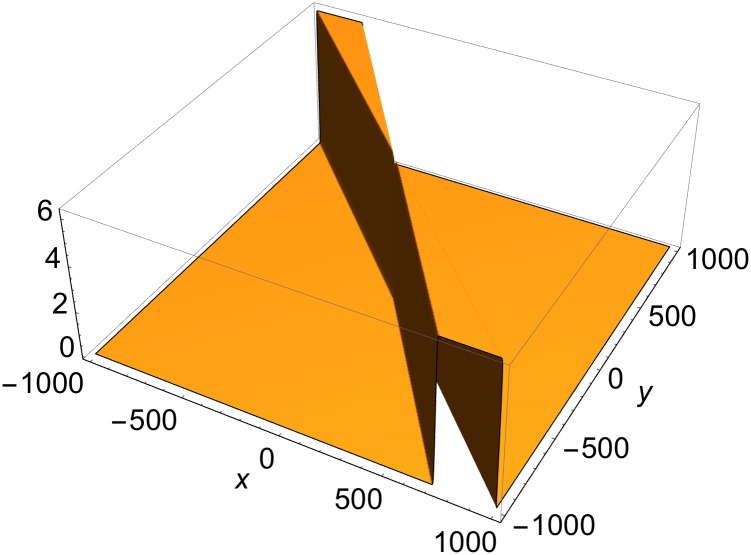
Two-front solution of Eq (1) at t = z = 0.p(1) = {1, cosφ(1), sinφ(1), 1}, p(2) = {1, cosφ(2), sinφ2, 1}; φ(1) = π/5, φ(2) = π/4; δ(1) = δ(2) = 0.